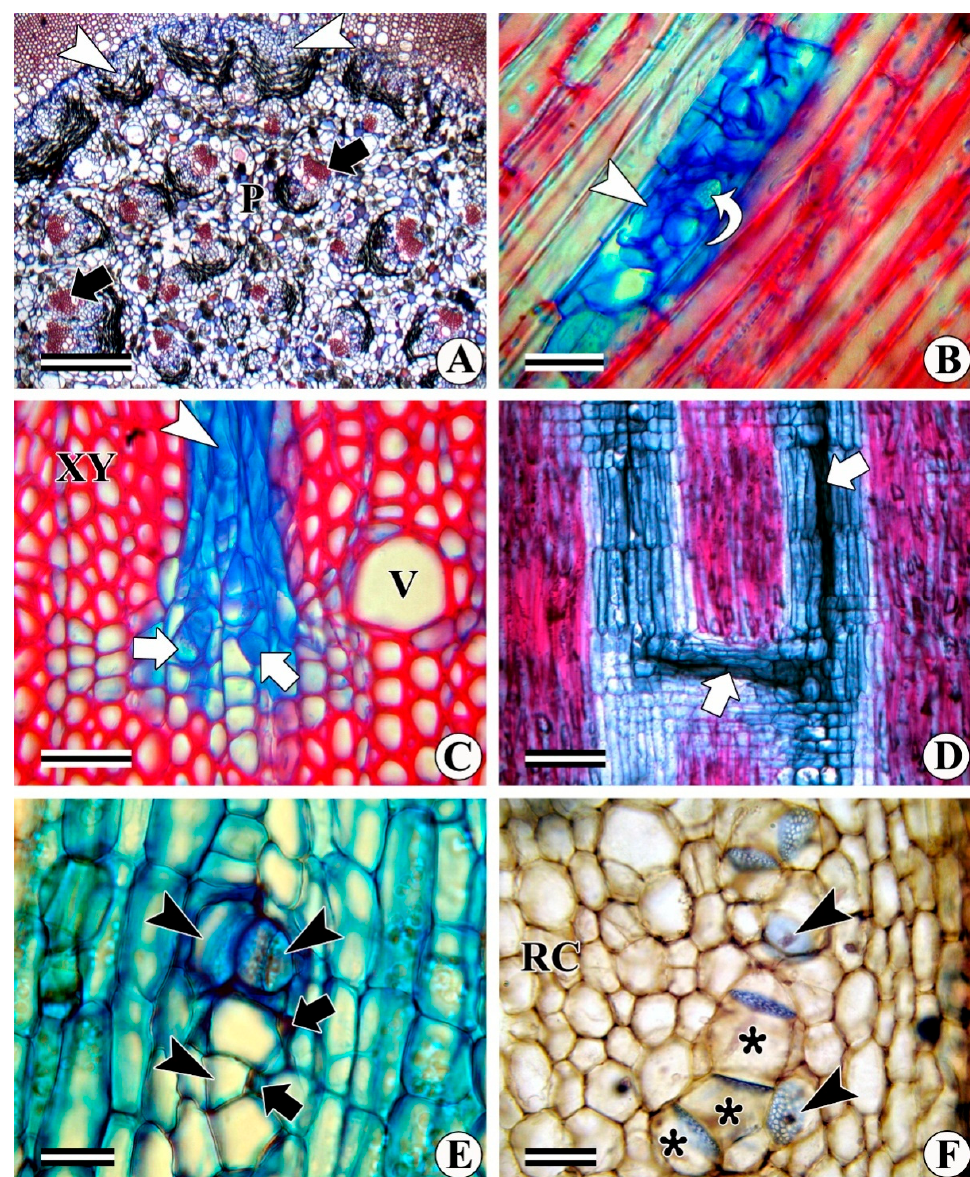
Figure 14. Fully grown mature stems showing medullary bundles ( A ) and ray sieve elements in different eudicots. ( A ) Fully grown mature plants showing an increased number of medullary bundles (arrows) in Argyreia nervosa . Arrowheads indicate intraxylary phloem, which was absent in the young stem (pl. see Figure 13C). ( B ) Tangential longitudinal (TLS) view of Leptadenia pyrotechnica secondary xylem showing radially oriented sieve element (curved arrow) in the xylem ray (arrow- head). ( C ) Transverse views of L. pyrotechnica stem showing sieve plates (arrows) in the xylem rays. Arrowhead indicates radially elongated ray sieve elements. ( D ) Adjacent interxylary phloem (arrows) showing anastomosing in Salvadora oleoides. ( E ) TLS view of Ipomoea hederifolia showing ray sieve element (arrowheads), with the arrows showing the companion cells. ( F ) TLS view of Erythrina indica showing ray sieve elements (arrowheads). Note the orientation of sieve elements shown with arrowheads and asterisks. Abbreviations : P = pith, RC = ray cells, V = vessel, XY = secondary xylem. Scale bars : ( A ) = 500 µ m, B, ( D – F ) = 50 µ m, ( C ) = 100 µ